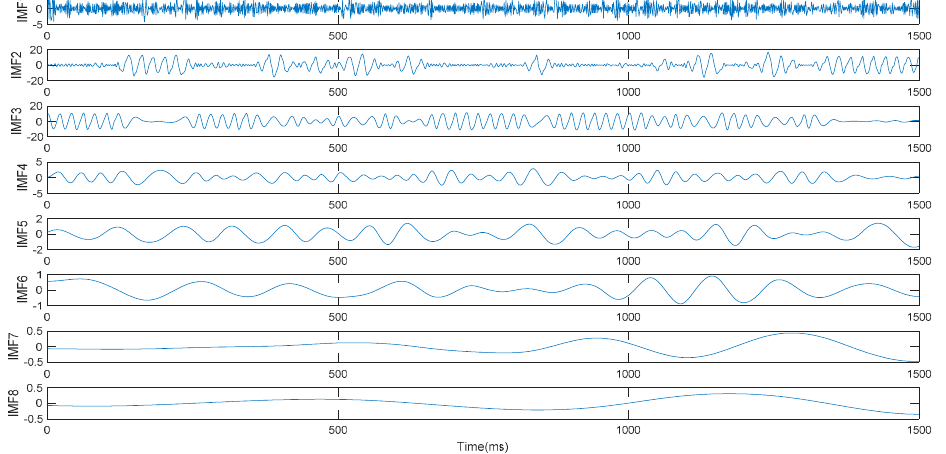
Figure 4. Intrinsic mode function (IMF) components obtained by the empirical mode decomposition (EMD) based on the C 2 Hermite interpolation algorithm.